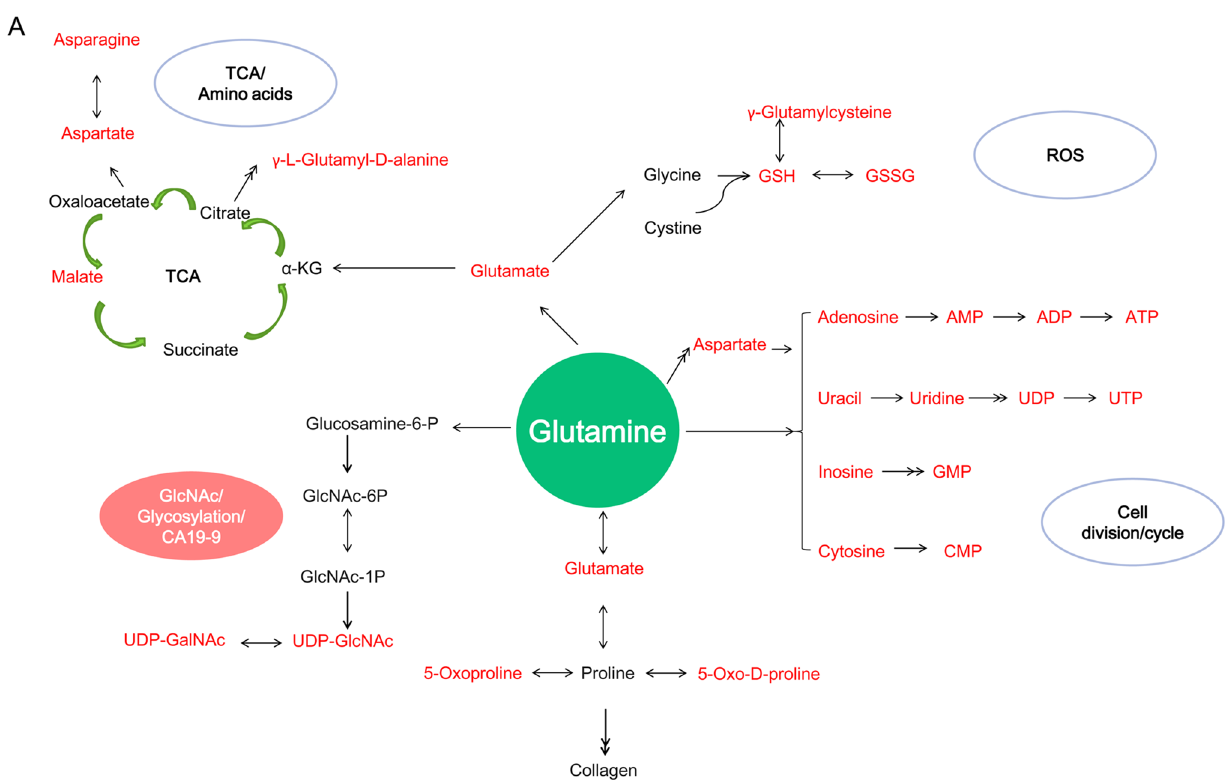
Fig. 3 Metabolic flux of glutamine in pancreatic cancer cells. A Main flow includes CA19-9 biosynthesis/glycosylation, collagen/stroma, TCA cycle, cell division, and ROS reaction detected by isotope tracing untargeted metabolomics using UHPLC-MS. Three replicates per condition. The double arrow represents multiple reactions using [U-13 C ]-L-glutamine or [U-15 N ]-L-glutamine as tracers. Blue circle, [U-13 C ]-L-glutamine; red circle, [U-15 N ]-L-glutamine. Red indicates metabolites have been traced by isotope. UHPLC-MS, ultrahigh performance liquid chroma- tography coupled with tandem Q-Exactive Orbitrap mass spectrometer. α-KG, α-ketoglutarate; TCA cycle, tricarboxylic acid cycle; ROS, reac- tive oxygen species; CA19-9, sialyl Lewis a; UMP, uridine monophosphate; UDP, uridine 5’-diphosphate; UTP, uridine 5’-triphosphate; ADP, adenosine 5’-diphosphate; ATP, adenosine 5’-triphosphate; AMP, adenosine 5’-monophosphate; CMP, cytidine-5’-monophosphate; GMP, guanosine 5’-phosphate; GlcNAc-6P, N-acetylglucosamine-6-phosphate; GlcNAc-1P, N-acetylglucosamine-1-phosphate; UDP-GlcNAc, UDP- N-acetylglucosamine; UDP-GalNAc UDP-N-acetyl-D-galactosamine, fructose-6P , fructose 6-phosphate, GSH reduced glutathione, GSSG glu- tathione